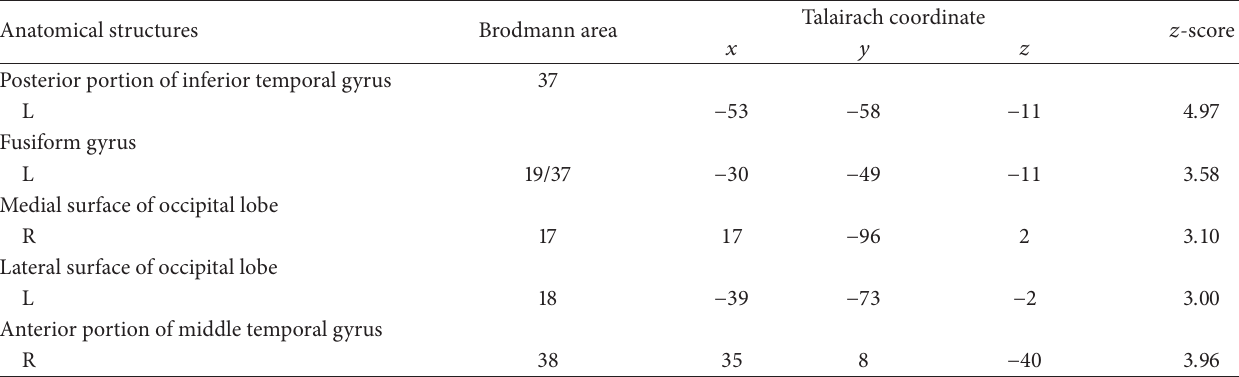
Table 2: Regions showing significant changes in rCBF by the subtraction of complex minus chord condition. Anatomical structures